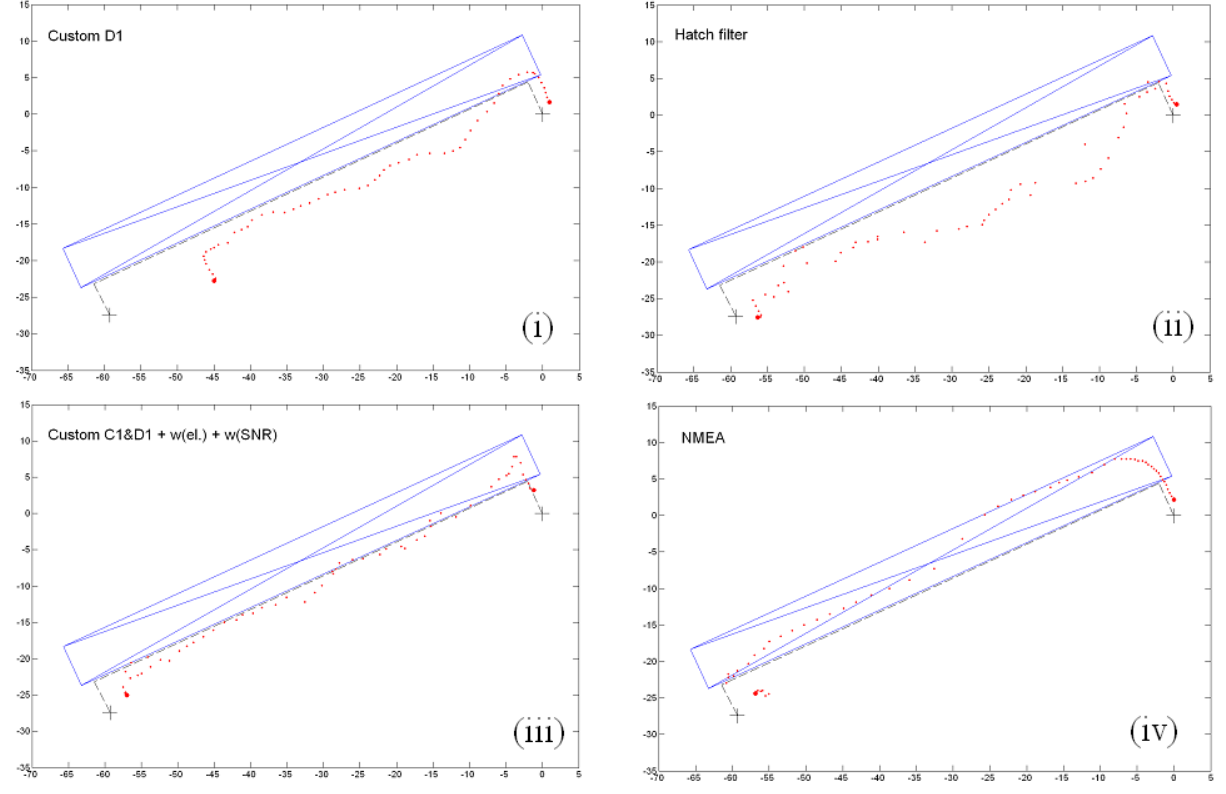
Figure 8. Solutions in a mixed-condition environment (e): (i) autonomous Doppler positioning with custom procedure; (ii) Doppler smoothing of code observations with the Hatch filter; (iii) custom positioning procedure with C1&D1, plus elevation angle weighting and SNR weighting; (iv) internal positioning of the receiver. Units are in